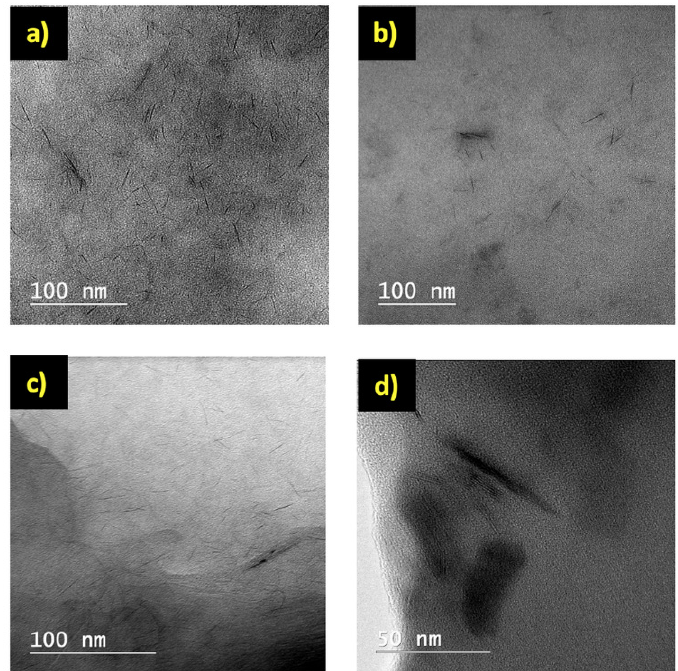
Figure 5. TEM images for the NC hydrogels. ( a ) HMBA 4 -XLG 10 ; ( b ) HDVE 4 -XLG 10 ; ( c ) HXLG 10 ; ( d ) non-exfoliated clay structures in HDVE 4 -XLG 10 .